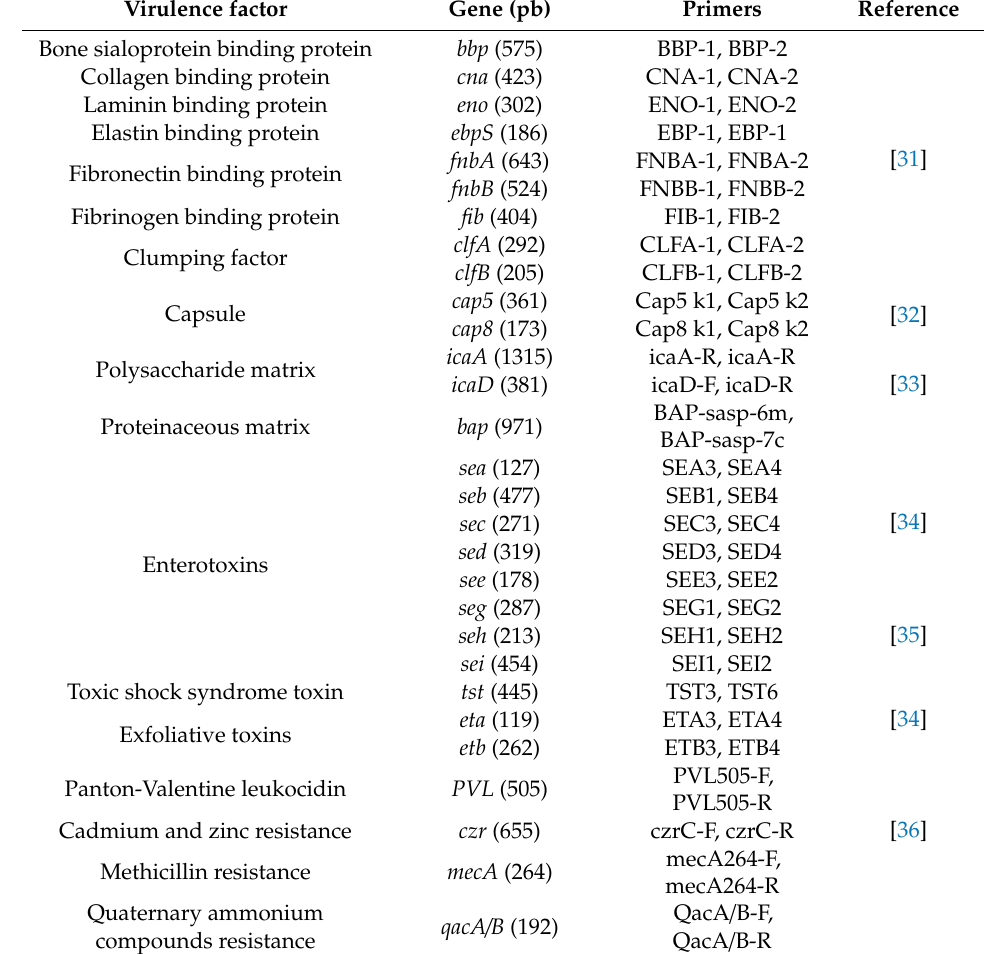
Table 2. Conditions of the PCR reactions used for the identification of virulence